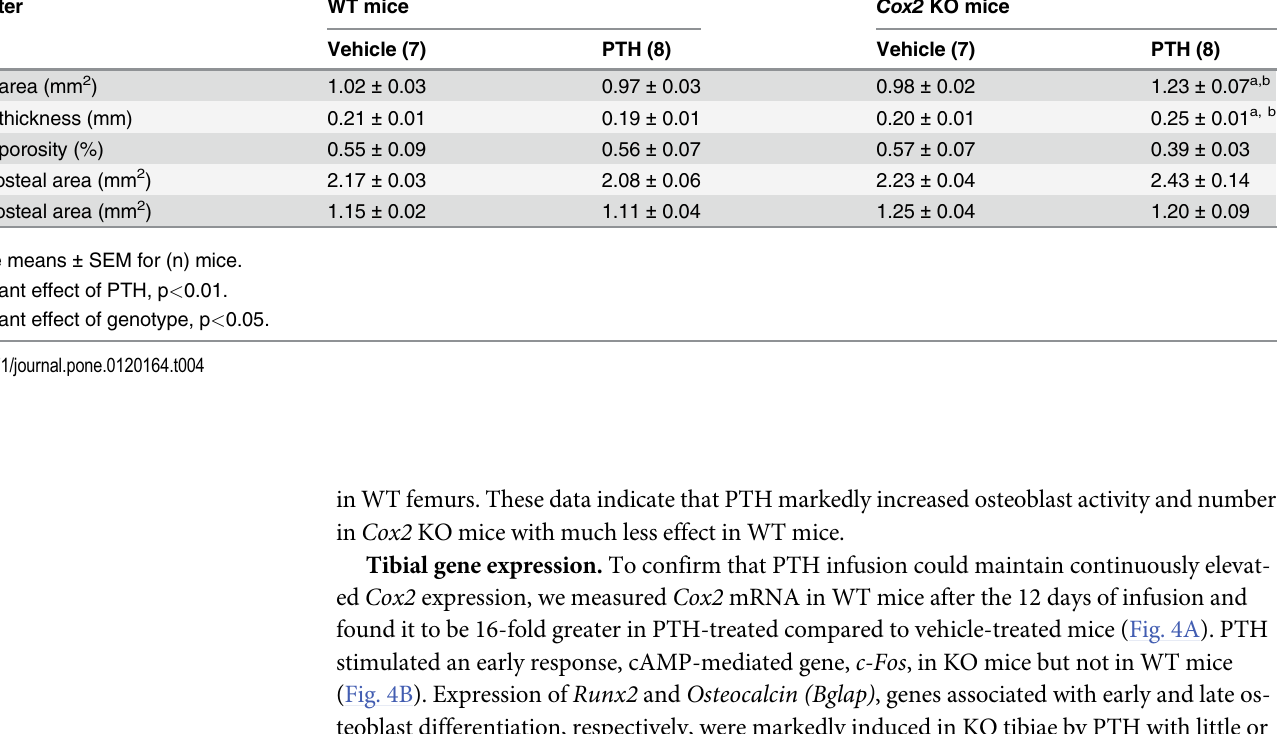
Table 4. Cortical morphometry by μ CT in the midshaft femoral region of WT and Cox2 KO mice after infusion with vehicle or PTH for 12 days. Parameter